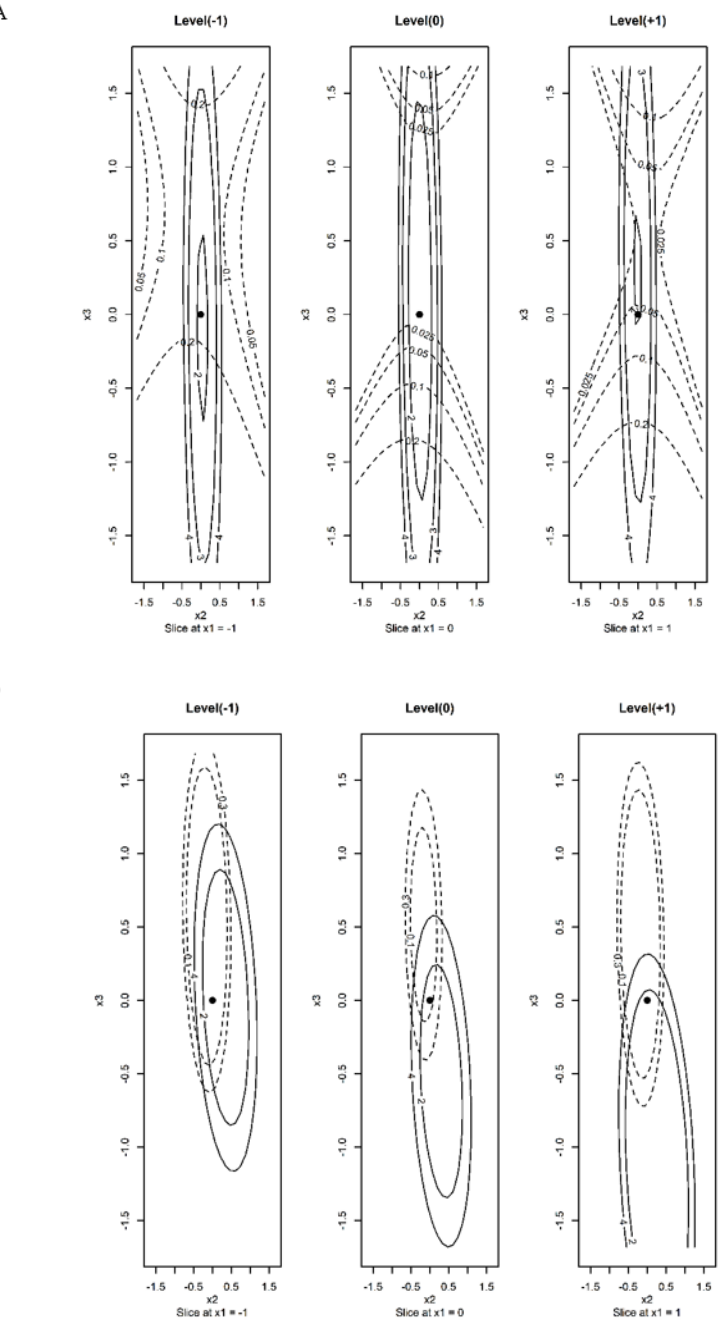
Figure 1. The 2D contour levels for the primary difference function [yi − 100] 2 (continuous line and secondary difference function [k’ − k’ goal ] 2 (dotted line) for the variables of the column temperature (X 1 ), flow rate (X 2 ), and formic acid content (X 3 ), corresponding to the INH ( A ), PZA ( B ), and RFP ( C ) drugs. The black points show the nominal conditions. In all situations, the level of variability for the % drug responses was around 2%, although this level was twice as large for INH, and a high content of formic acid was observed.